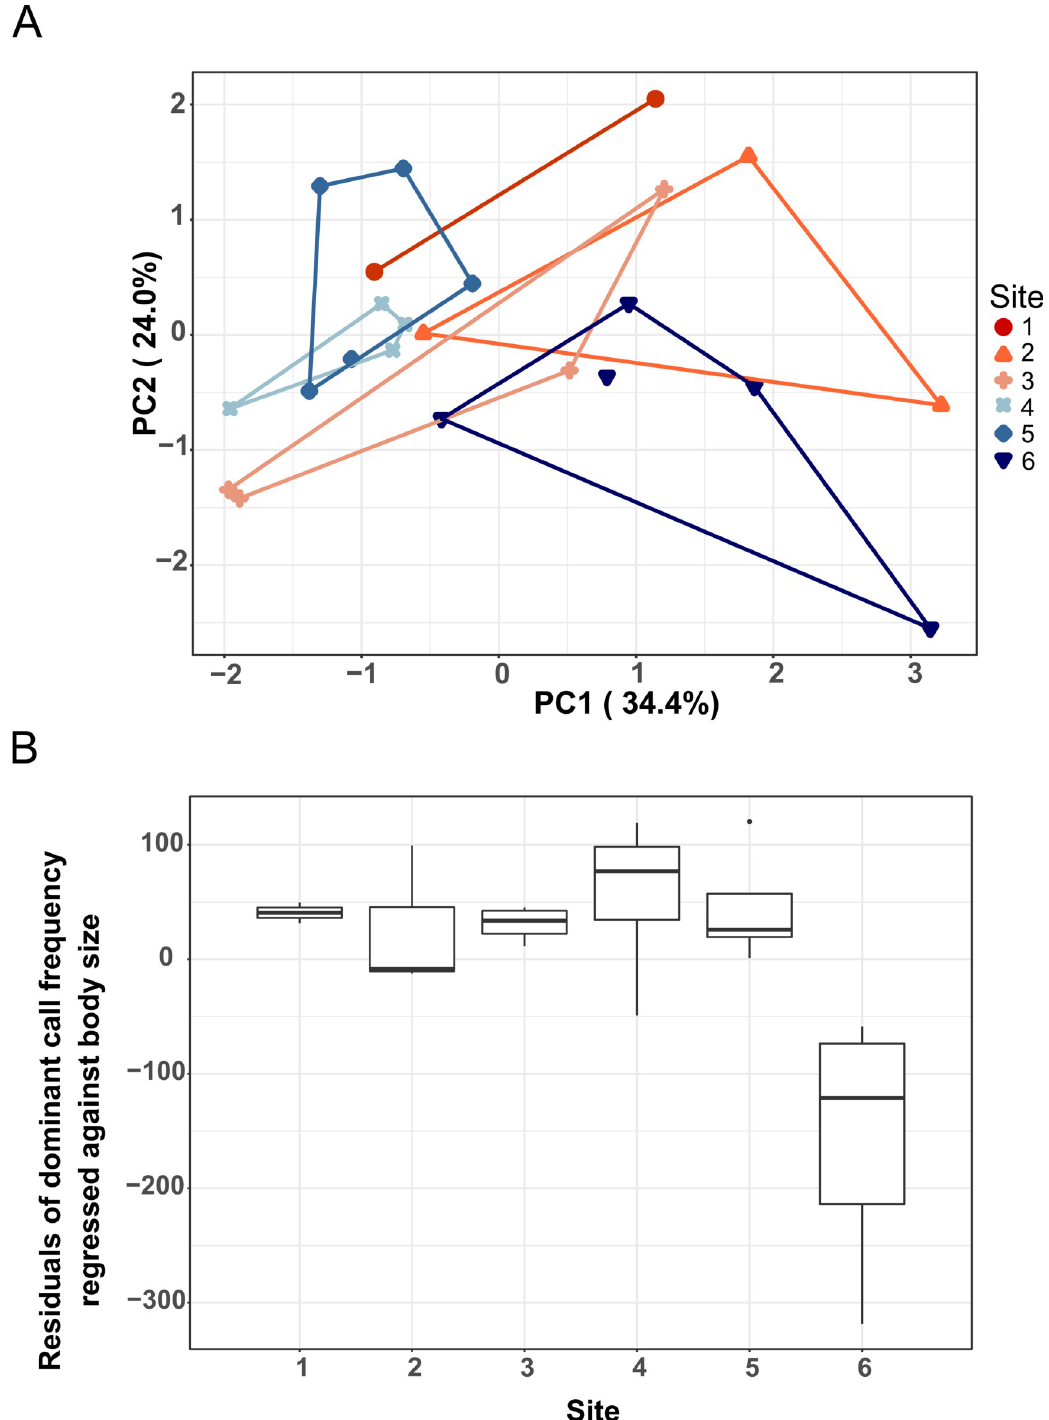
Fig 4. Analyses of call parameters of Mantidactylus bellyi . A] Principal Component Analysis (PCA) of the temporal and spectral call parameters, corrected for body temperature (T b ) for temporal call characters and body size (SVL) for dominant call frequency by regression. Convex hulls were drawn for call scores of specimens belonging to different sites on the first two principal components. Each dot symbolizes average values of multiple calls per individual. The colors correspond to those in Fig 2A. B] Variation of the residuals of dominant call frequency regressed against body size of calling Mantidactylus bellyi between different study sites in Montagne d’Ambre National Park.